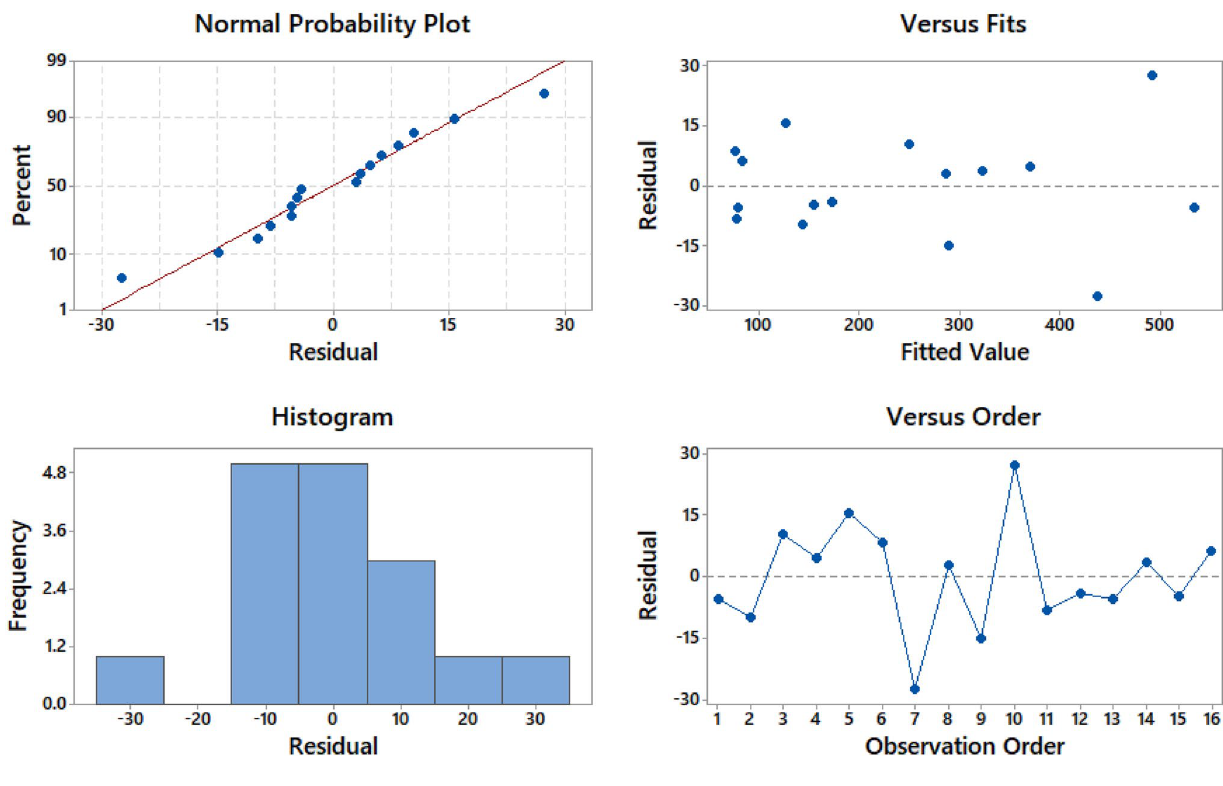
Fig. 20 Residual plot of the cutting force F x forSiCp/Al 45% [40]